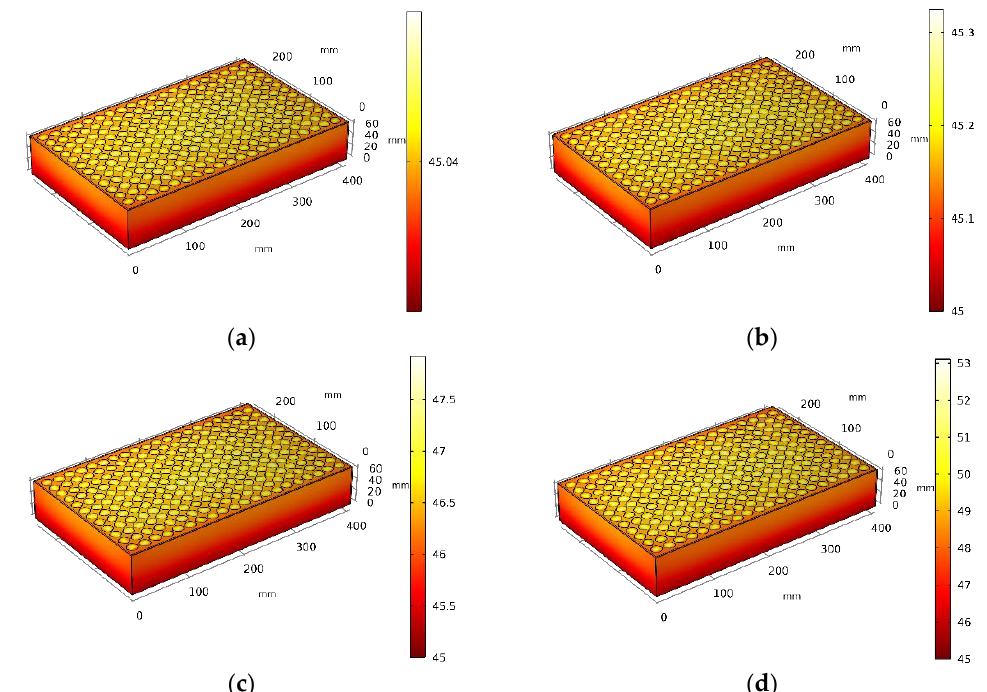
Figure 5. Temperature contours of the entire battery pack in Al housing with different C rates ( a )